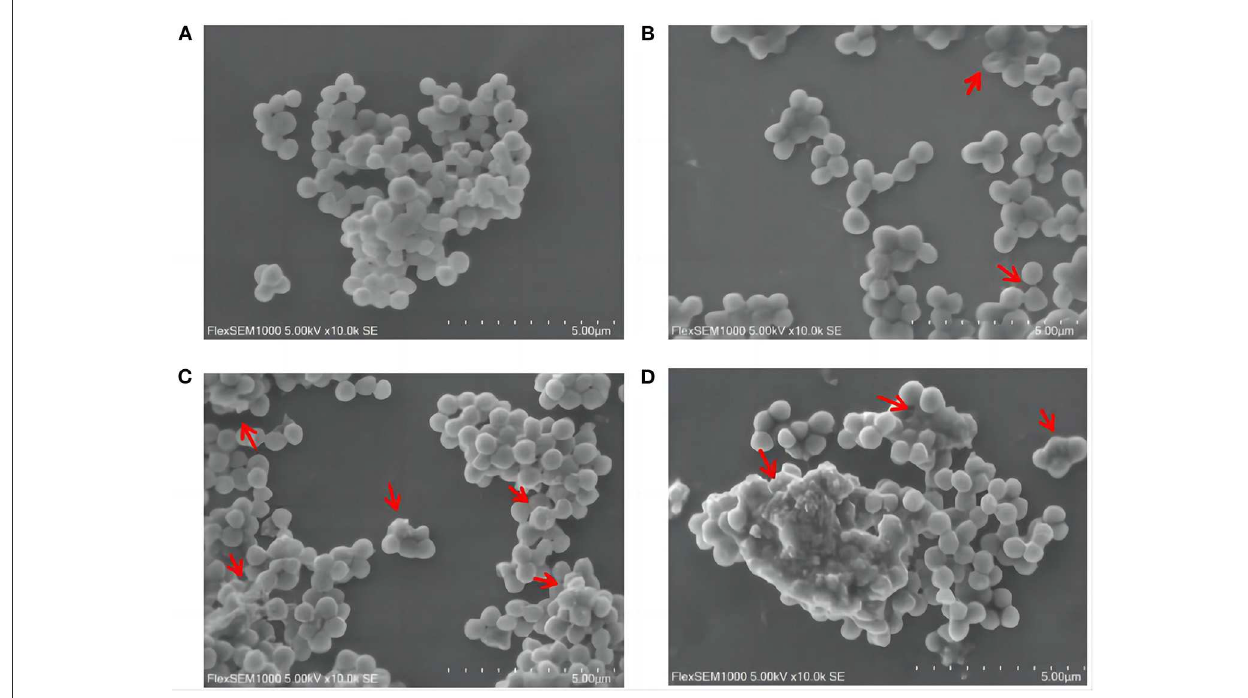
FIGURE2 Effects of SGCH on the morphology of SA cells. (A) 0 × MIC group treated with 0.3% DMSO for 24h. (B) 2 × MIC group treated with SGCH for 24h. (C) 4 × MIC group treated with SGCH for 24h. (D) 8 × MIC group treated with SGCH for 24h. The arrows in the figure indicate SA cells had obvious